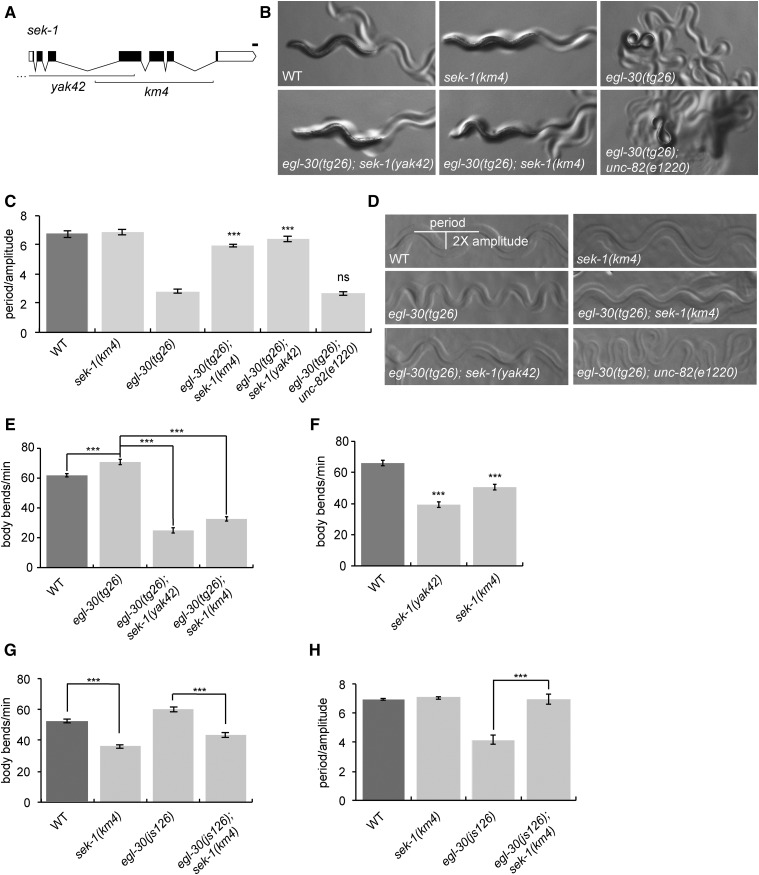
sek-1 acts downstream of Gαq to modulate locomotion behavior. (A) Gene structure of sek-1. White boxes depict the 5′ and 3′ untranslated regions, black boxes depict exons, and lines show introns. The positions of the yak42 and km4 deletions are shown. yak42 is a 3713-bp deletion that extends to 1926 bp upstream of the start codon. Drawn with Exon-Intron Graphic Maker (http://www.wormweb.org/exonintron). Bar, 100 bp. (B–D) sek-1(yak42) and sek-1(km4) suppress the loopy waveform of the activated Gq mutant egl-30(tg26). unc-82(e1220) does not suppress egl-30(tg26). (B) Photographs of first-day adult worms. All photos were taken at 60× magnification. (C) Quantification of the waveform phenotype. Error bars = SEM, n = 5. *** P < 0.001; ns, P > 0.05 compared to egl-30(tg26). (D) Photographs of worm tracks. (E) The activated Gq mutant egl-30(tg26) is hyperactive and is suppressed by sek-1(yak42) and sek-1(km4). Error bars = SEM, n = 20. *** P < 0.001. (F) sek-1 mutant worms have slow locomotion. Error bars = SEM, n = 20. *** P < 0.001 compared to wild type. (G) sek-1(km4) suppresses the hyperactive locomotion of the activated Gq mutant egl-30(js126). Error bars = SEM, n = 20. *** P < 0.001. (H) sek-1(km4) suppresses the loopy waveform of the activated Gq mutant egl-30(js126). Error bars = SEM, n = 5. *** P < 0.001. WT, wild type.